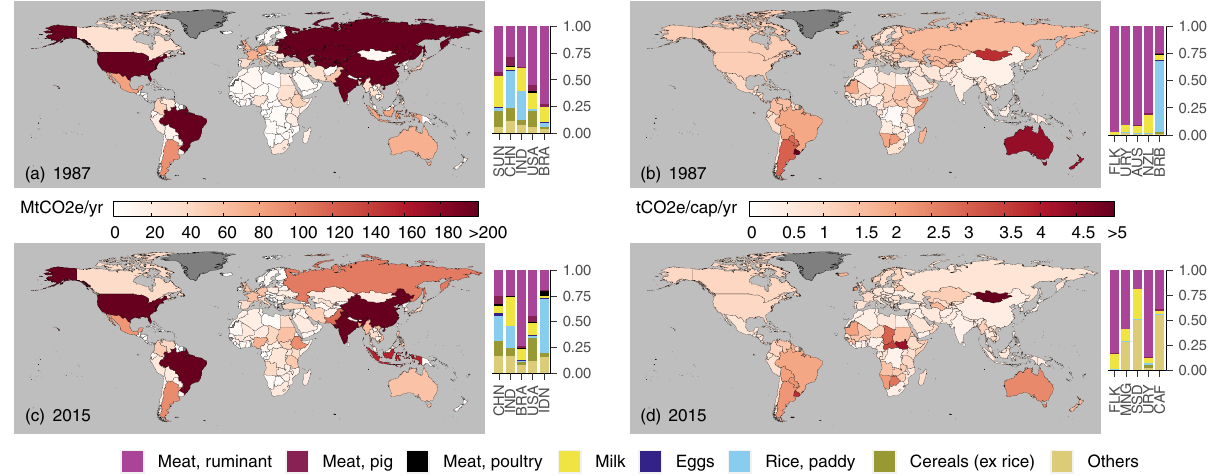
Fig. 1 Trade-adjusted agricultural emissions (TAEs) in 1987 and 2015. Total absolute TAEs are shown on the left ( a , c ), and per capita TAEs are shown on the right ( b , d ). A darker red colour indicates higher TAE levels, whereas dark grey colours indicate countries with no available data (e.g., Greenland). In addition, the bar graphs show the top fi ve countries with the largest total absolute and per capita TAEs, in decreasing order from left to right. The bars also consist of the relative contributions of each food group to these TAEs. Country names are shown according to their respective UN ISO 3166-1 alpha-3 codes, i.e., Australia (AUS), Brazil (BRA), Barbados (BRB), Central African Republic (CAF), China, mainland (CHN), Falkland Islands (FLK), Indonesia (IDN), India (IND), Mongolia (MNG), New Zealand (NZL), South Sudan (SSD), USSR (SUN), United States of America (USA), and Uruguay (URY).